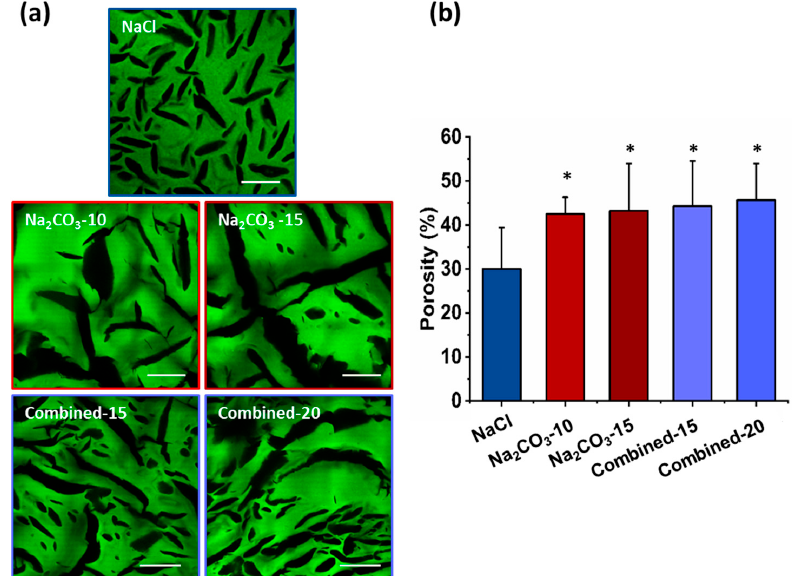
Figure 2. Hydrogels’ porosity after hydration. ( a ) Representative confocal microscopy images of the ff erent sca ff olds containing Dextran-FITC. Scale bar 200 µ m. ( b ) Sca ff olds’ porosity calculated from different scaffolds containing Dextran-FITC. Scale bar 200µm. ( b ) Scaffolds’ porosity calculated from di confocal stacks images in A. Statistics were performed using student t -test. Only NaCl sca ff old